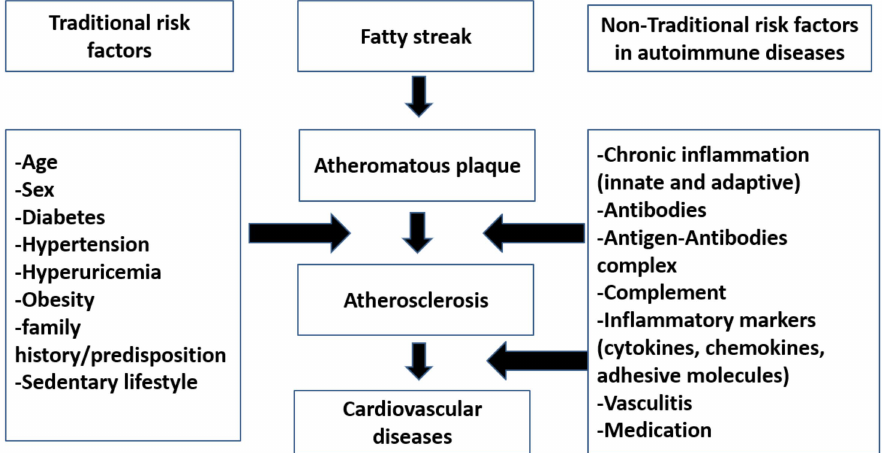
Figure 2. An overview of roles of traditional versus nontraditional risk factors in atherosclerosis in autoimmune